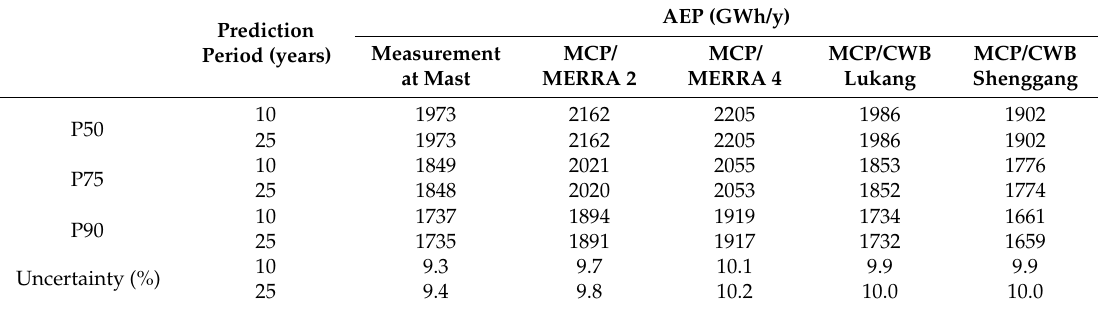
Figure 16. AEP values of P50, P75, and P90 predicted for 10 and 25 years by using measured mast data, MCP data from MERRA data of locations 2 and 4, and CWB data of Lukang and Shenggeng. Table 11. AEP of P50, P75, and P90 predicted for 10 and 25 years using measured mast data, MCP data derived from MERRA data of locations 2 and 4, and CWB data of Lukang and Shenggeng.